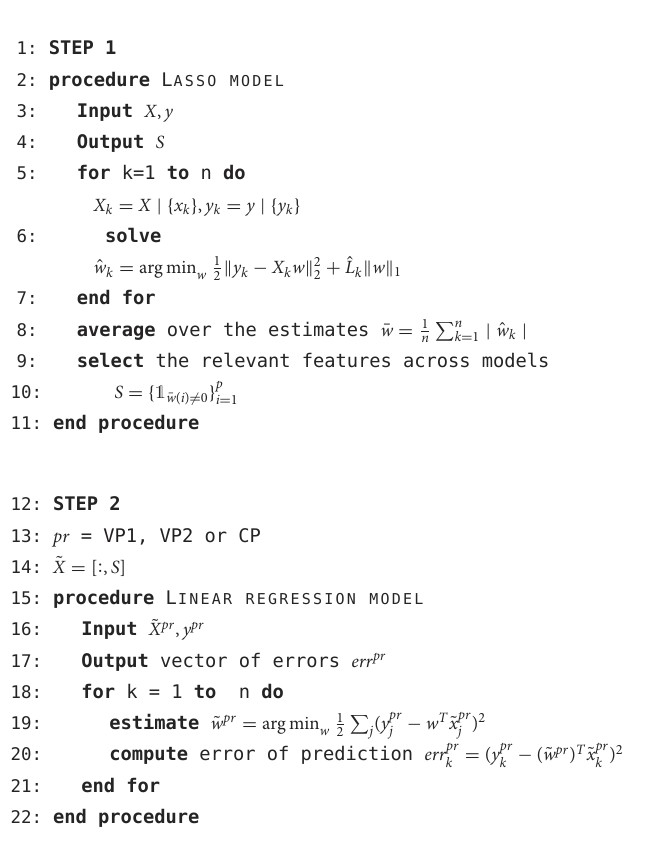
Algorithm 1. Two-stage model (one indicator case)